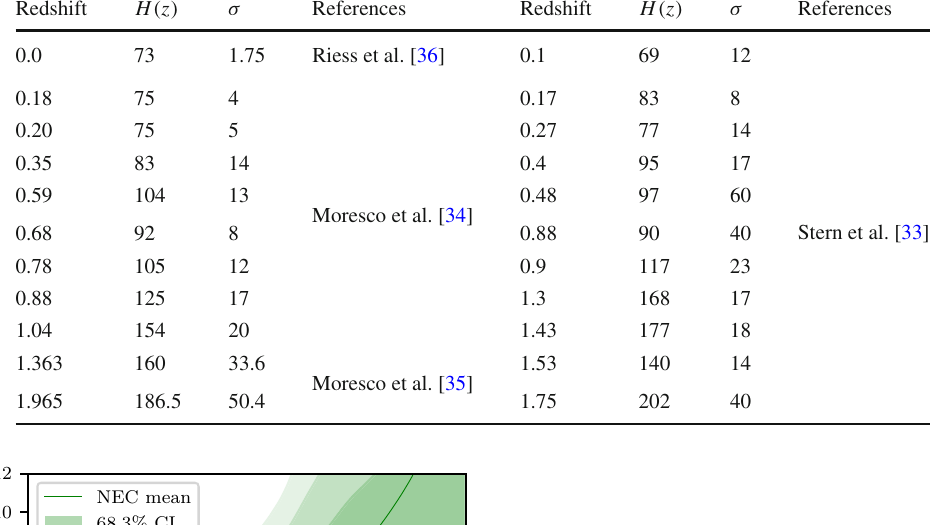
Table 2 Cosmic-chronometer